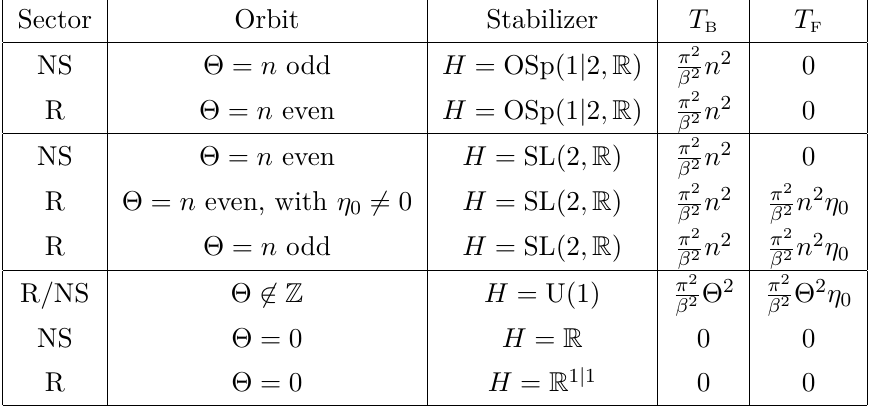
Table 2 . Constant-representative sVirasoro